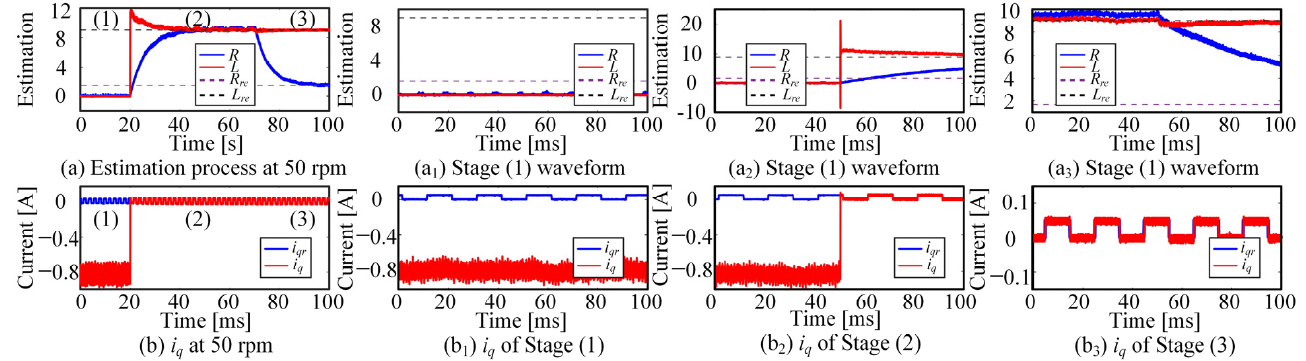
Figure 12. The parameter identification results at 50 rpm.